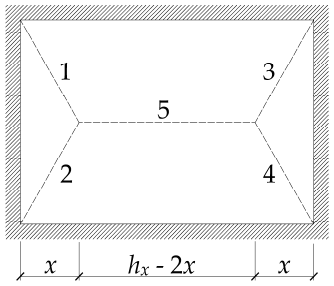
Figure 5. Distribution of plastic hinge lines when the concrete retaining wall is